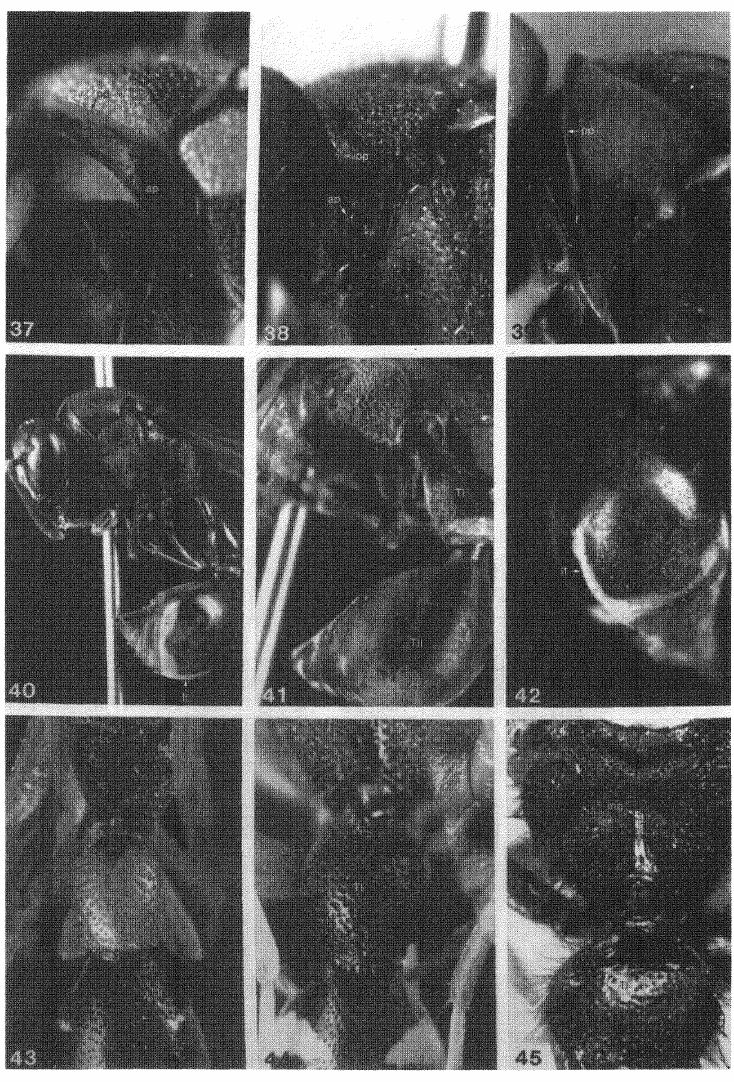
Figs. 37-45. 37-39. Lateral view of pronotum. 37. Metaparagia doddi holo- type, 13)<. 38. Parachartergus apicaloides, 13)<. 39. Polistes anduzeL 10)<. 40. Paramasaris cupreus 6)<. Lateral view. 41. P. richardsL 8)<. Oblique